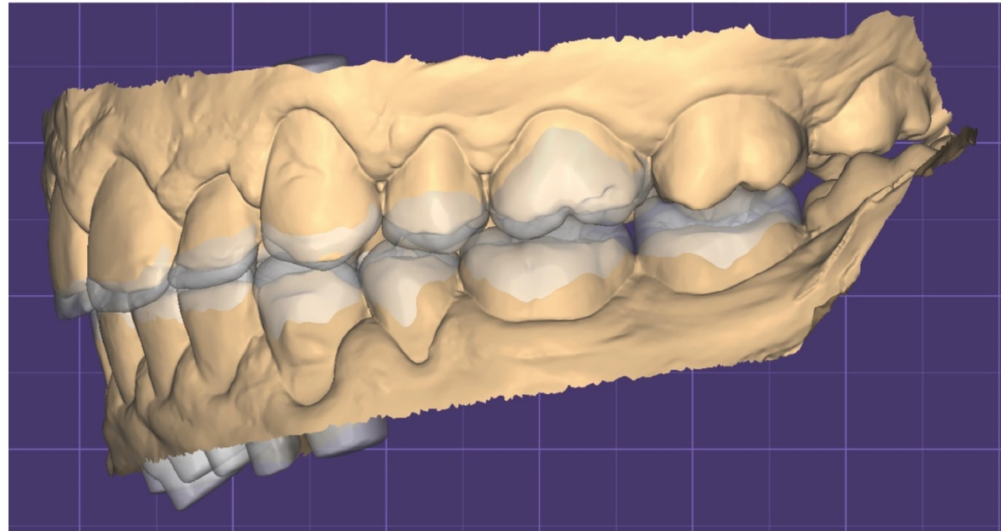
Figure 12. STL Digital wax up (left).